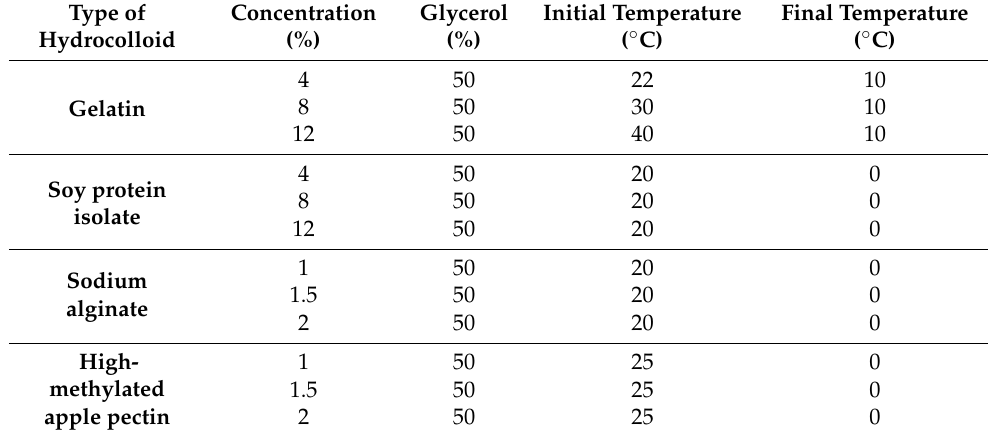
Table 1. Raw material composition and temperature of the subjects of film-forming solutions. Type of Concentration Glycerol Initial Temperature Final Temperature Hydrocolloid (%) (%) ( ◦ C) ( ◦ C) Gelatin